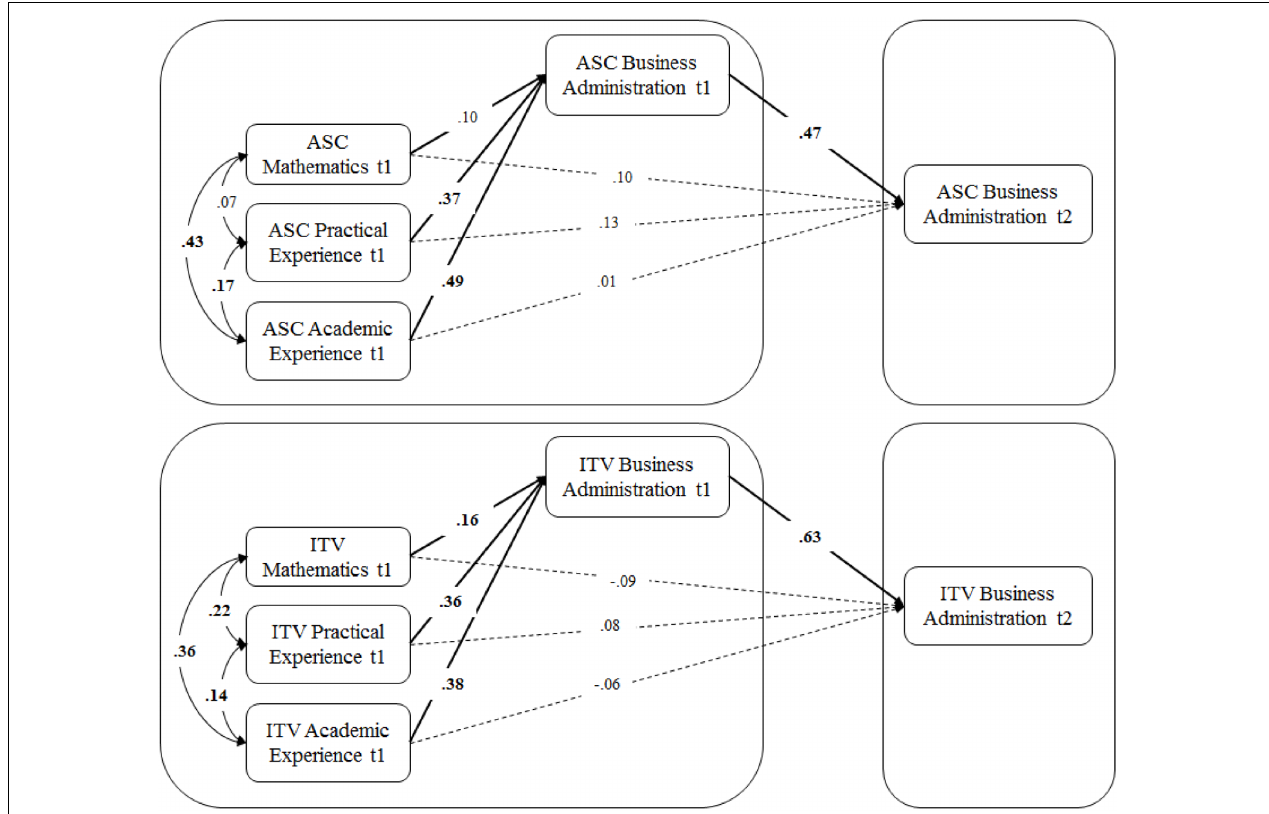
FIGURE 4 | Structural equation models (SEM) of predictors of first-year students’ academic self-concept and intrinsic task value, respectively, and stability over the first semester. ASC, academic self-concept; ITV, intrinsic task value; significant coefficients ( p < 0.05) are printed in bold, for further description see text. AcASC, academic experience-specific ASC; PrASC, practical experience-specific ASC; AcITV, academic experience-specific ITV; PrITV, practical experience-specific ITV.